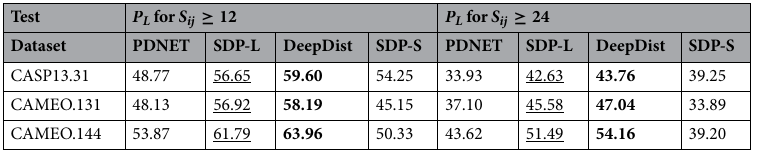
Table 4. Precision values P L (%) for top contact pairs when sequence separation lengths S ij = | i − j | are at least 12 or 24. For P L , the larger the better. The emboldened and underlined values are the best and the second best values respectively.